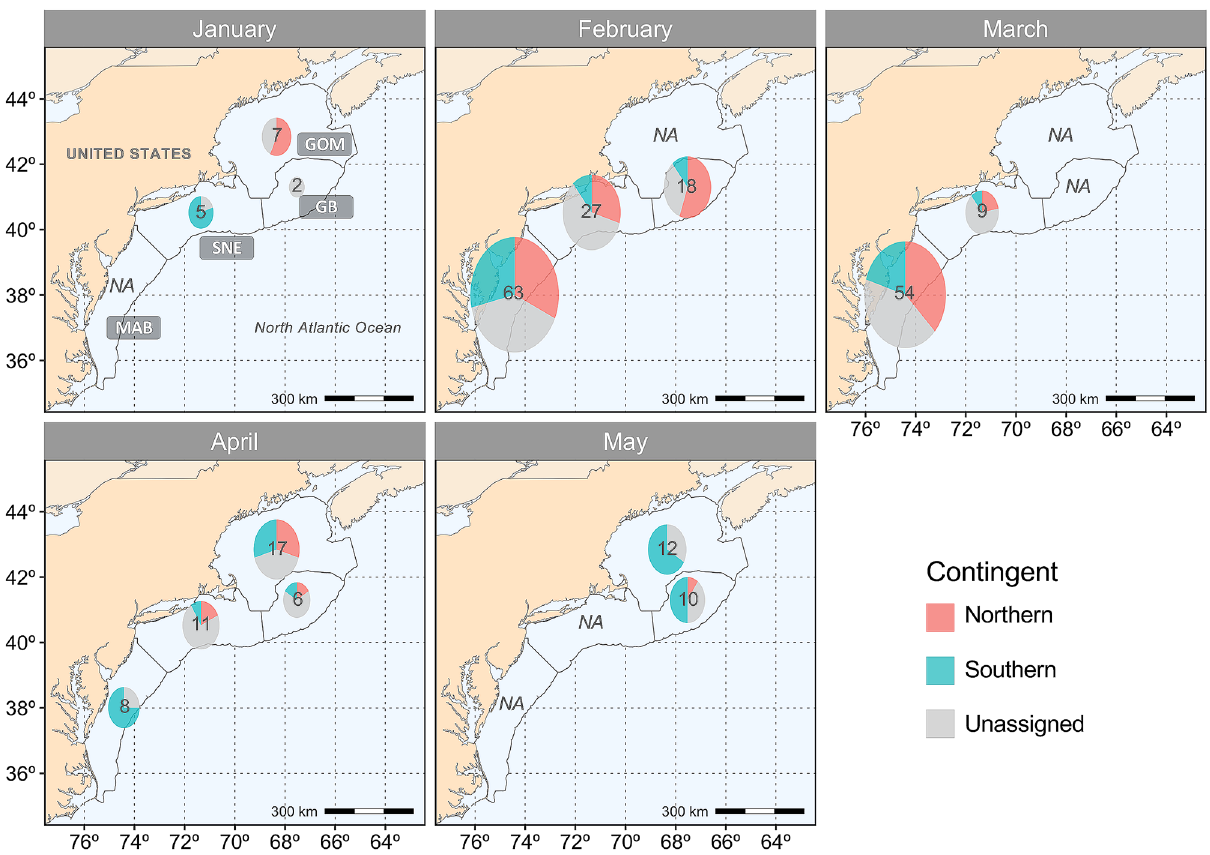
Figure 6. Contingent composition of Northwest Atlantic mackerel age ≥ 2 adult samples by region at capture through January and May collected in 2013–2019. The four regions (MAB, SNE, GB, GOM) are shown in outlined boxes. Each pie chart indicates the number of samples collected within each region, and is proportional to the sample size. The map was created in R using the ggplot2 package version 3.3.2 URL: https:// ggplo t2. tidyv erse. org 73 .